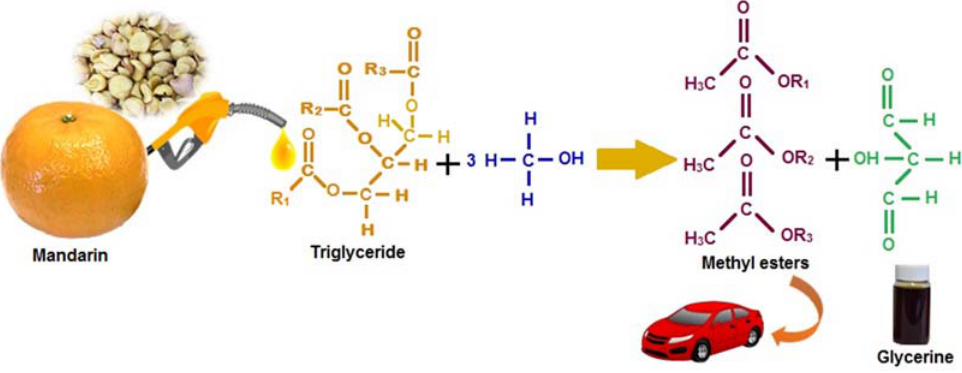
Figure 1. Summary of biodiesel production from mandarin oil.